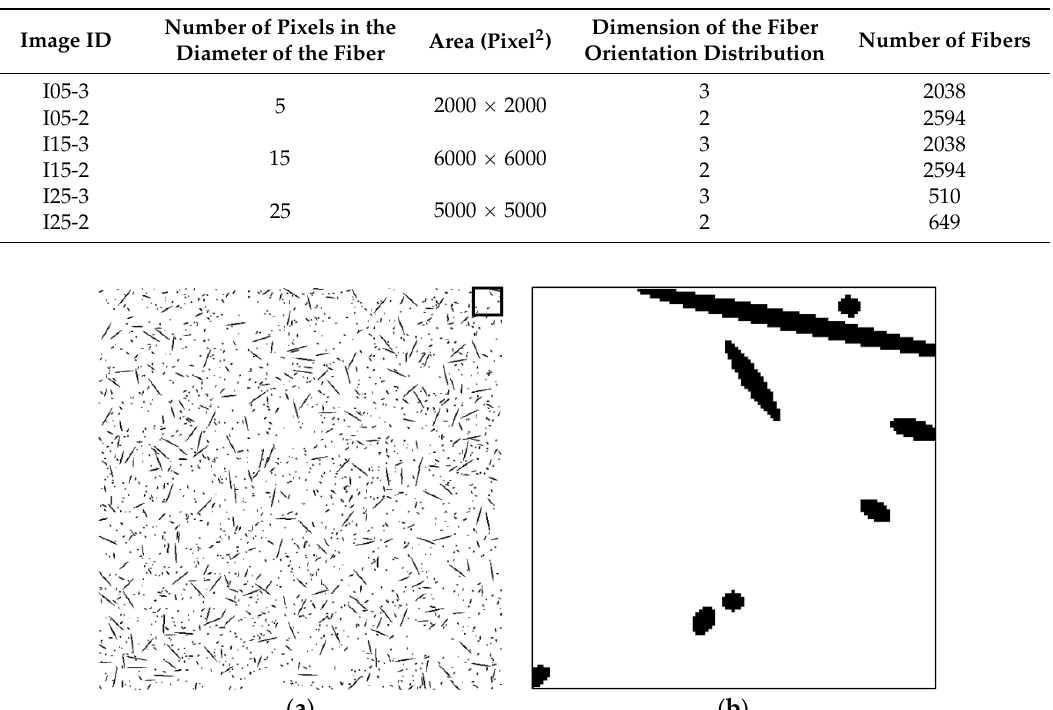
Figure 4. Artificial fiber images with a diameter of five pixels in a three-dimensional random distribution in the area of 2000 pixels by 2000 pixels (I05 ‐ 3): ( a ) section image and ( b ) magnified image.